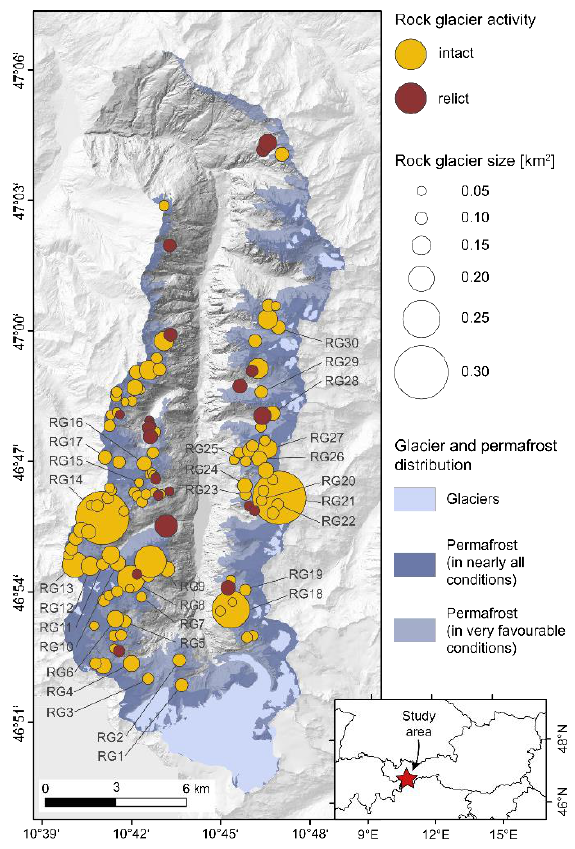
Figure 1. Distribution of intact and relict rock glaciers in the Kaunertal valley [49]. Rock glaciers are shown as colour-coded dots scaled to the planimetric size of individual landforms. Numbers indicate specific rock glaciers referred to in text and figures. Light blue, blue and dark blue areas show the mapped distribution of glaciers [44] and modeled coverage of permafrost occurrence in very favorable conditions and nearly all conditions [45], respectively.